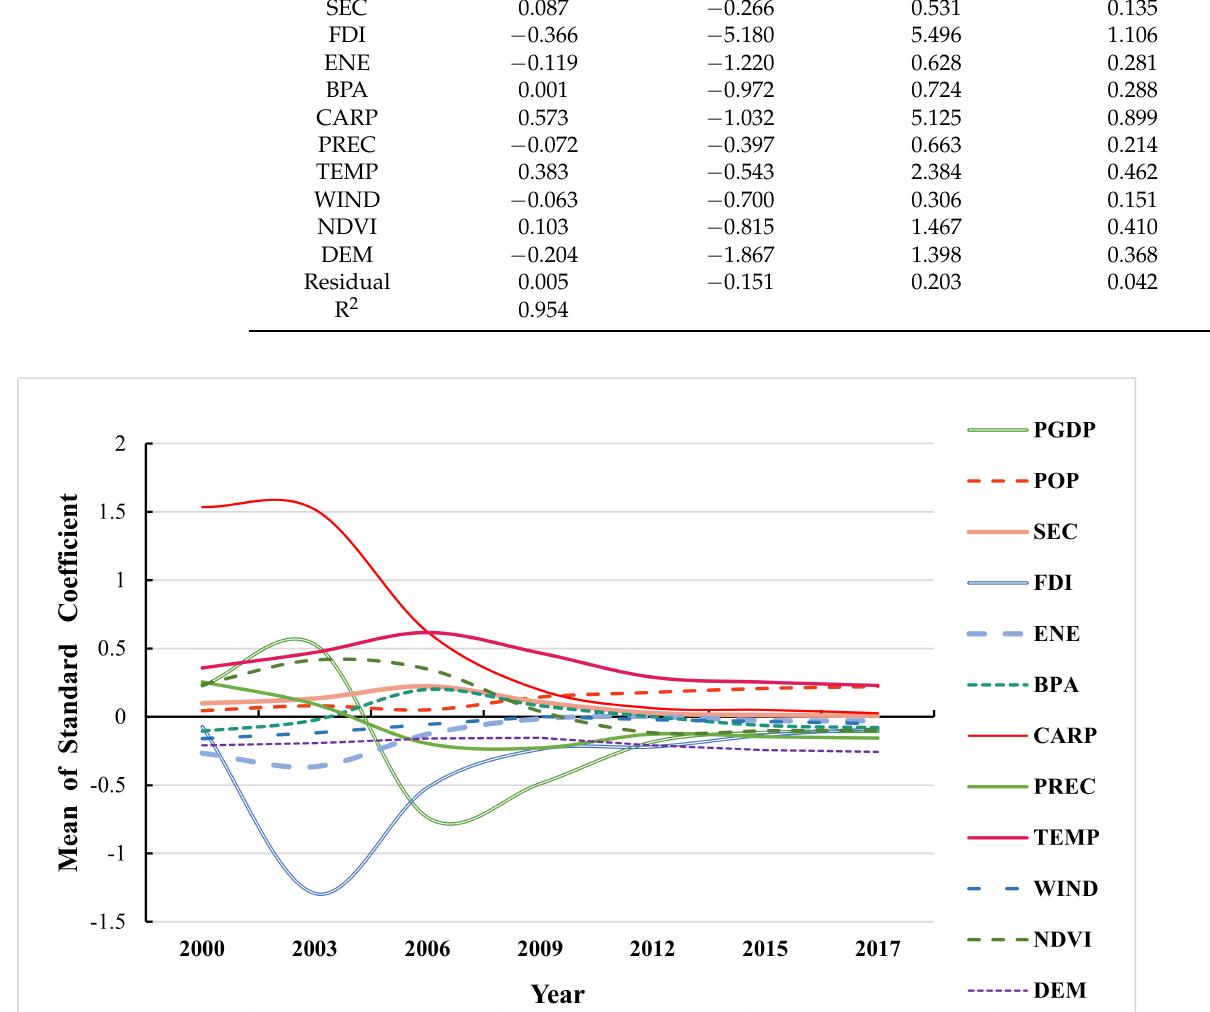
Figure 8. Temporal variation in regression coefficients of PM 2.5 concentrations explanatory variables from 2000 to 2017 based on GTWR